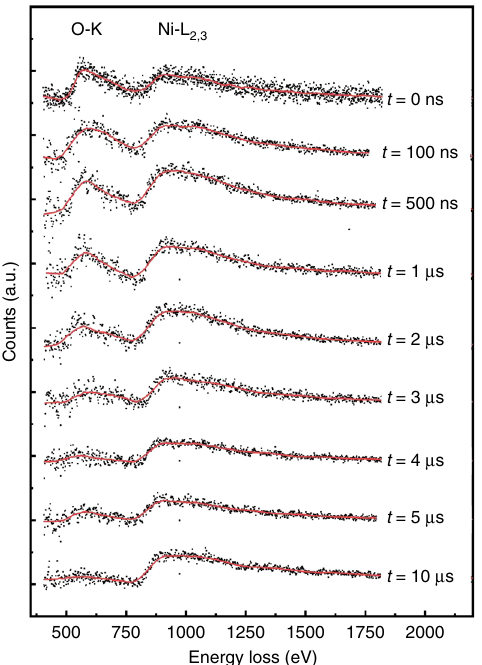
Fig. 3 Time-resolved EELS. Electron energy-loss spectra taken with single 7 ns electron pulses at different times after the IR laser